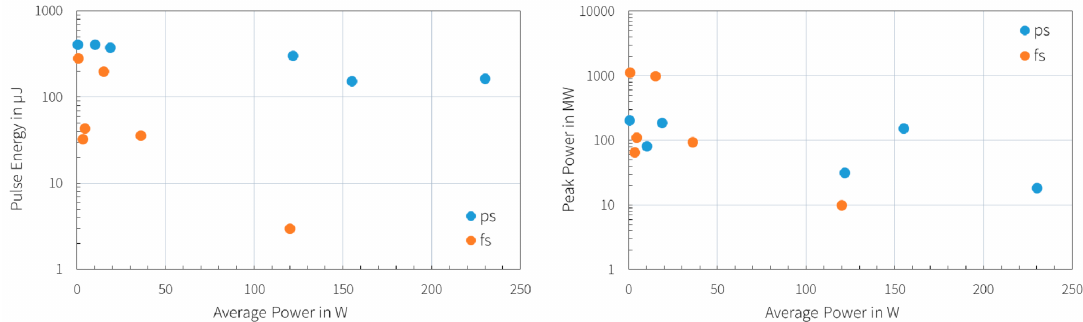
Figure 6. Overview of pulsed laser values which could be coupled and transmitted successfully using the flexible beam delivery. Each dot represents a parameter pair of the laser source. Picosecond and femtosecond laser systems are separately